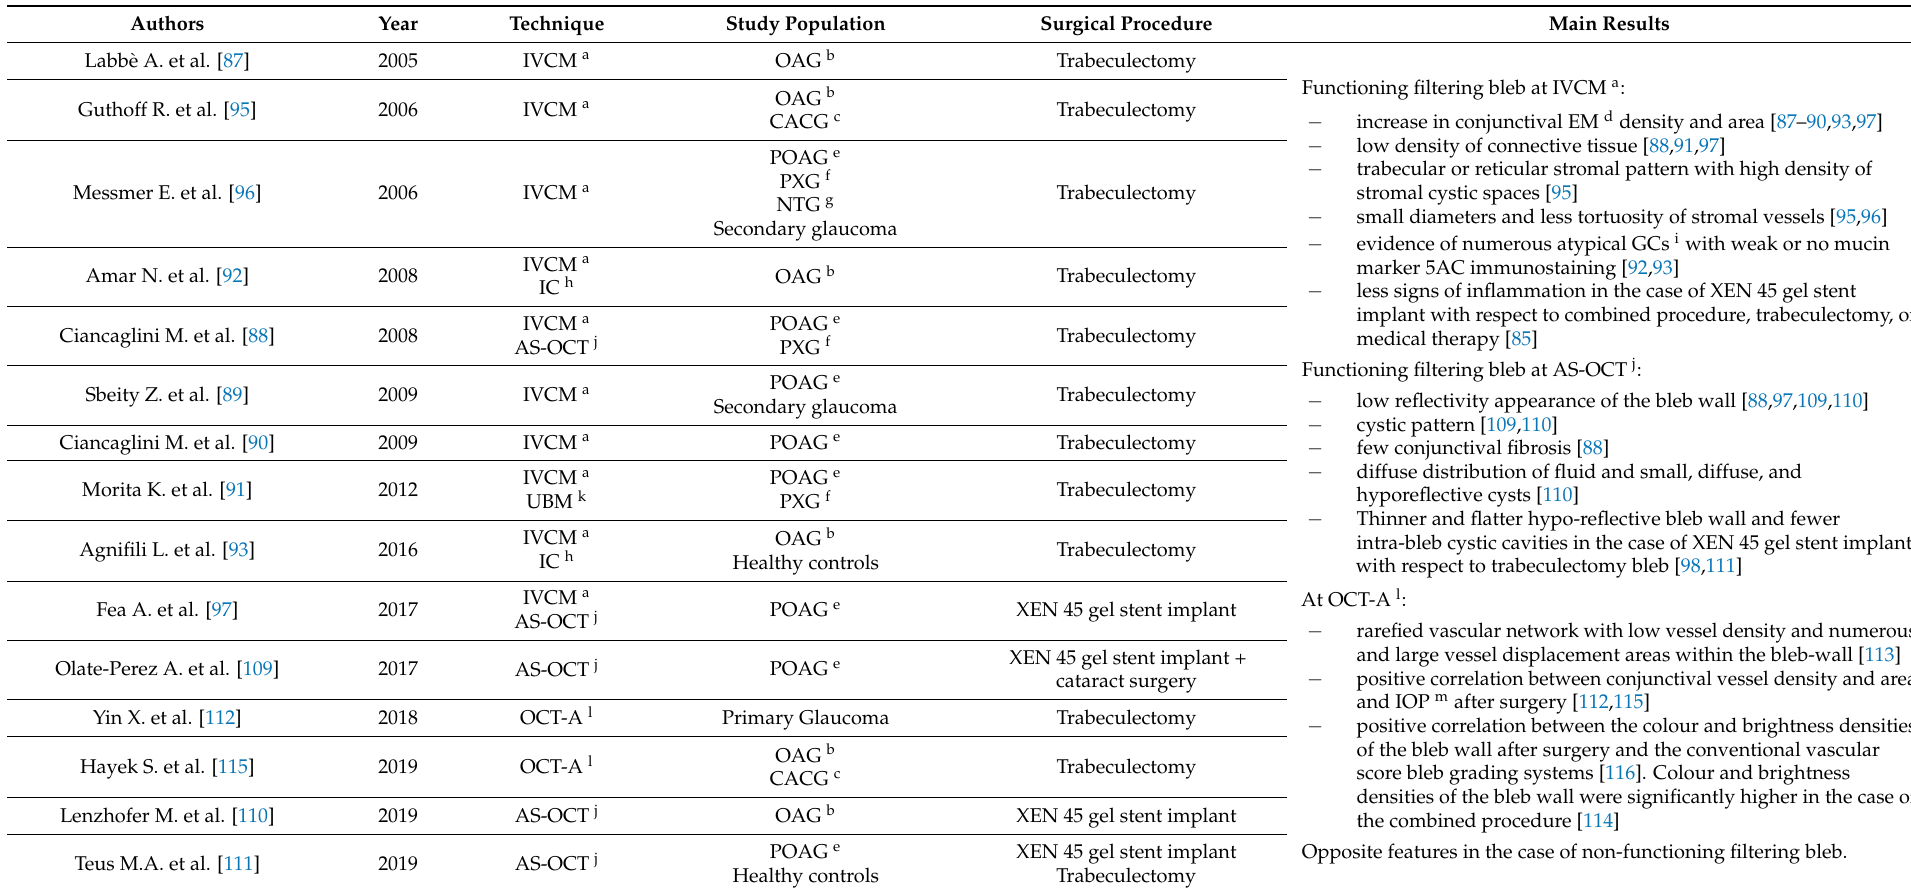
Table 3. Summary of clinical studies evaluating the main features of functioning glaucoma filtering bleb using IVCM, AS-OCT, and